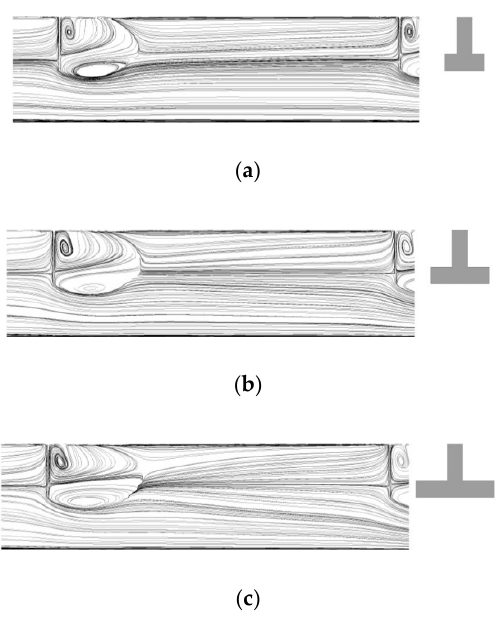
Figure 13. Streamlines on x-y plane (z = 0) between fifth and seventh ribs for different e/W. ( a ) e/W = 0.067, ( b ) e/W = 0.10, ( c ) e/W = 0.133.